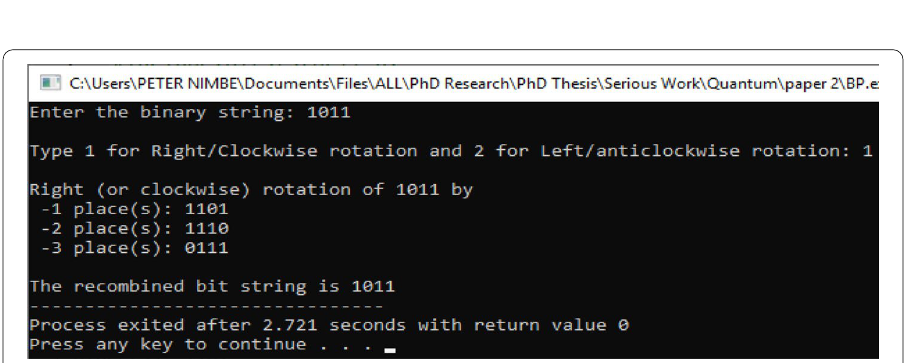
Fig. 18 Right or clockwise rotation of